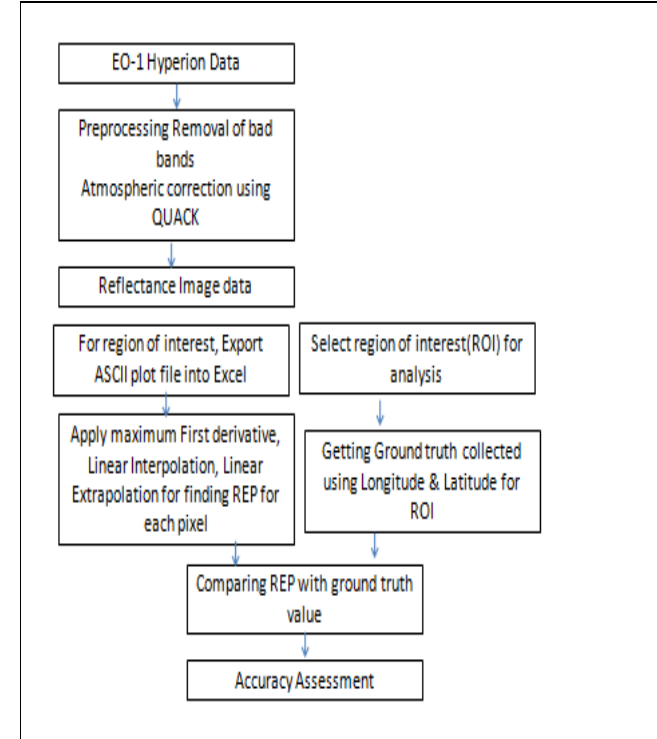
Figure 3: Methodology